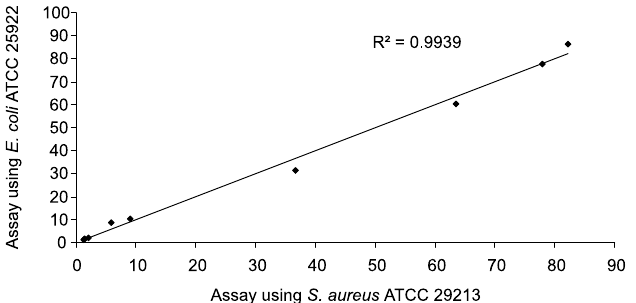
FIGURE 5 - Comparative in vitro drug release profiles of optimized time-dependent release bilayer tablet containing AMT using S. aureus and E. coli as test organisms. TABLE V - Antibacterial activity indicating the ZOI of samples obtained from in vitro drug release study of time-dependent bilayer release matrix tablet of amoxicillin trihydrate against S. aureus ATCC29213 and E. coli ATCC25922